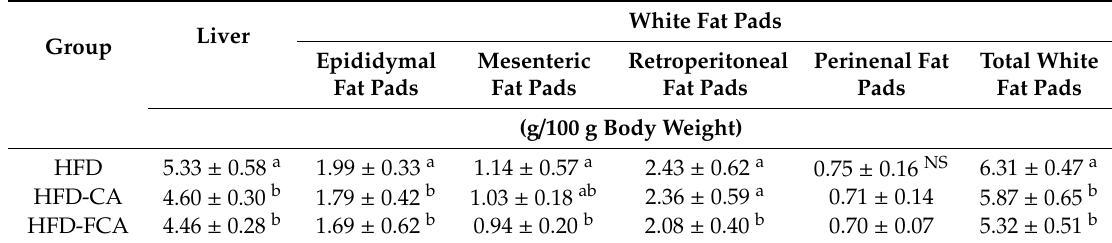
Table 3. Changes in the relative weight of the liver, mesenteric, epididymal, retroperitoneal, and total adipose tissues in rats fed experimental